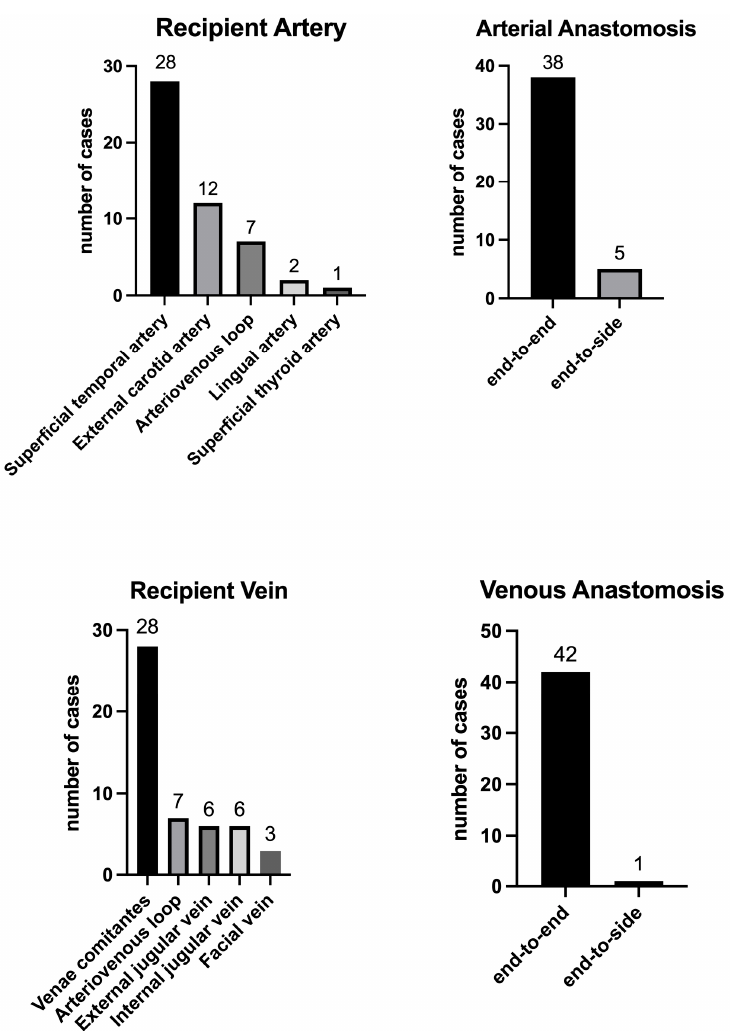
Figure 3. This diagram depicts the surgical details considering recipient vessels and technique of